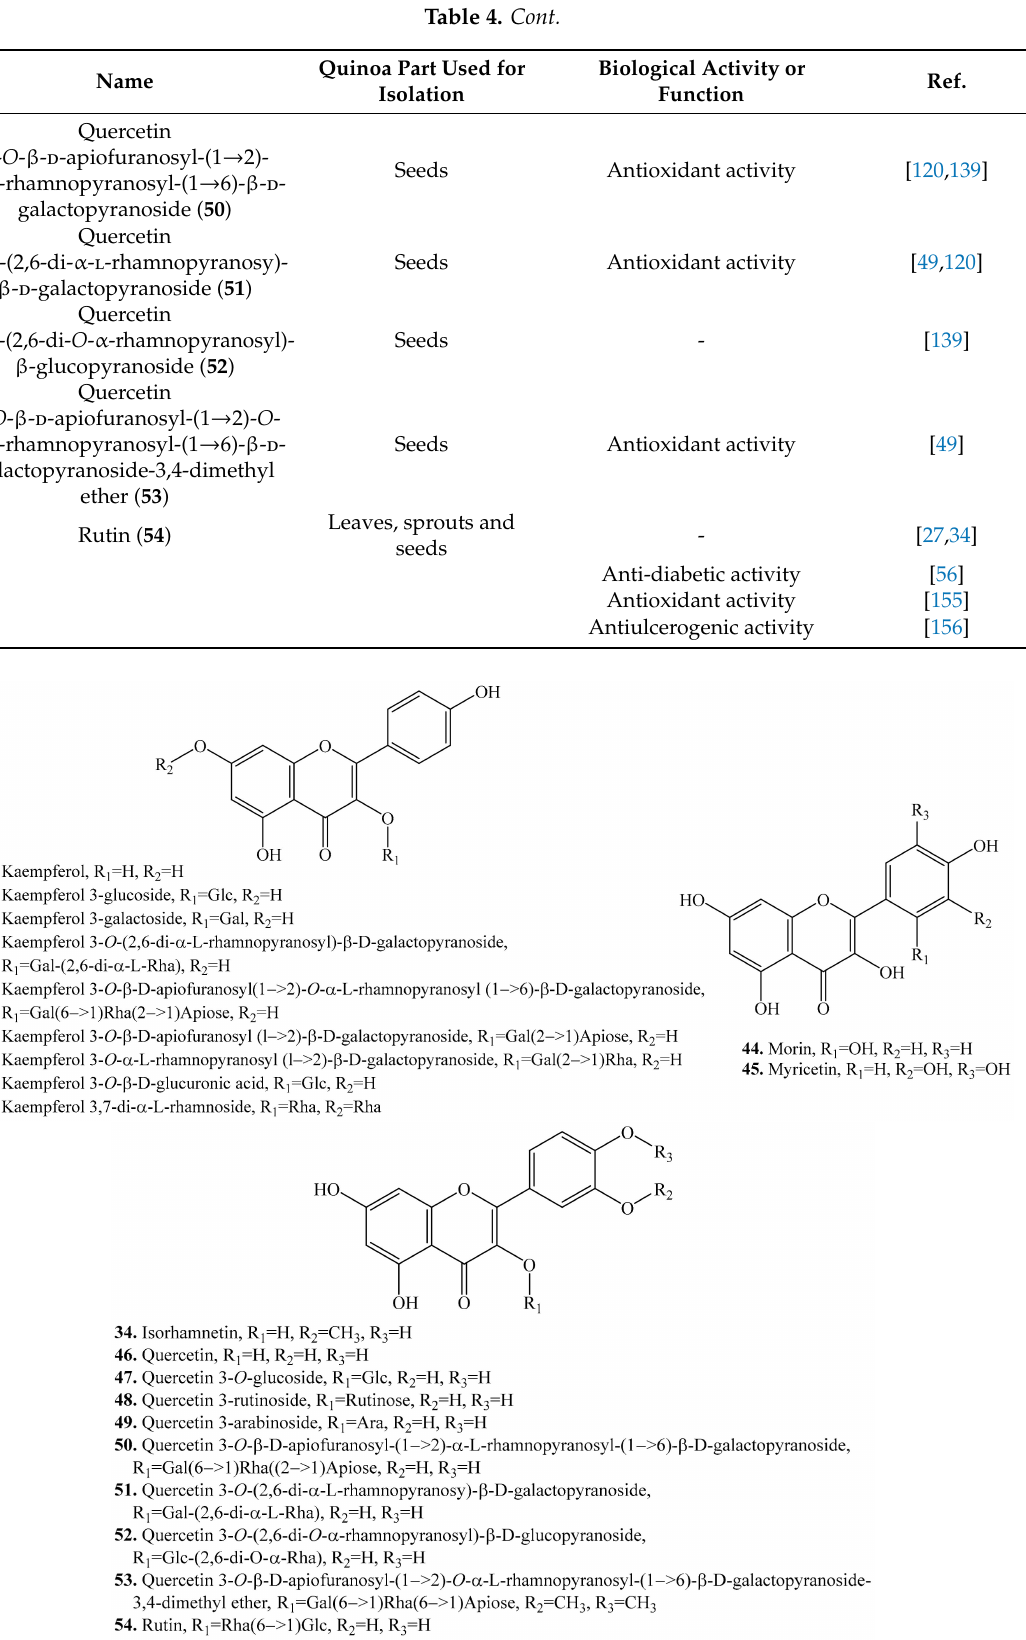
Figure 4. Structures of the flavonols isolated from